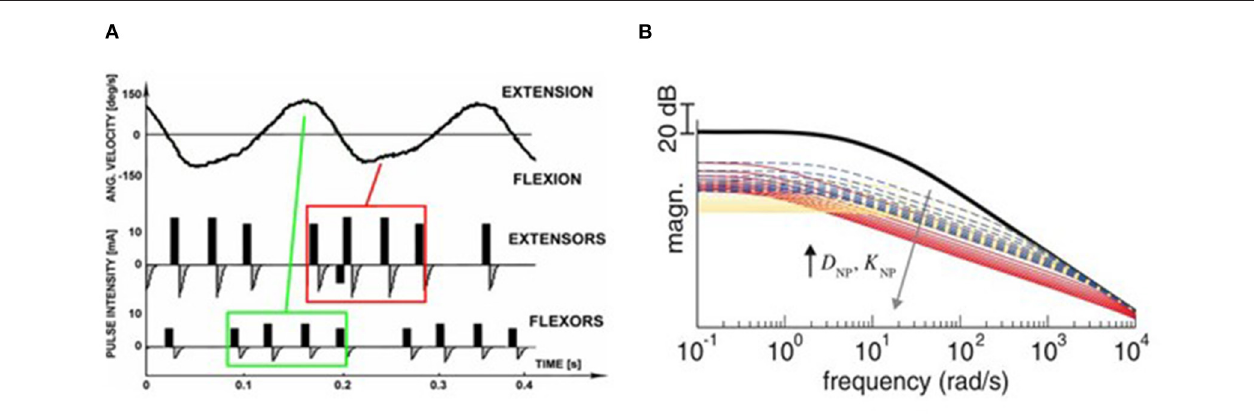
FIGURE 2 | Stimulation strategies for tremor suppression. (A) Out-of-phase. The top panel shows the angular velocity of the joint when rest tremor occurred. The antagonist muscle was electrically stimulated when the agonist muscle was active (Maneski et al., 2011). (B) Co-contraction. The human joint impendence was modeled with the use of the stiffness and viscosity variables D NP and K NP determined by the stimulation parameters. Equal increments of D NP and K NP are shown as broken lines, larger increments of D NP than K NP are shown as red lines while larger increments of K NP than D NP are shown as yellow lines. The high frequency response of the joint can be attenuated so that the tremor was suppressed (Alvaro Gallego et al., 2013a).